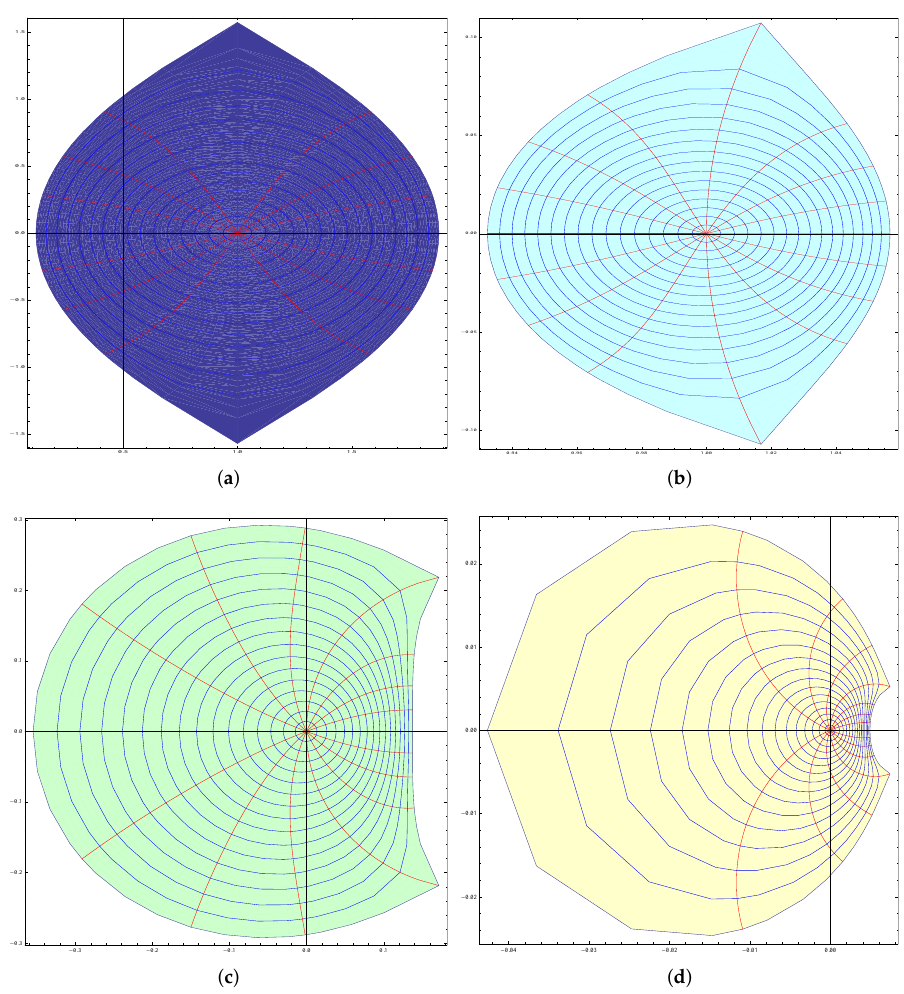
Figure 1. Impact of N ( A , B , ψ ) − 1 on ψ ( z ) = 1 + sinh − 1 ( z ) . ( a ) Mapping of E under the transfor- mation ψ ( z ) = 1 + sinh − 1 ( z ) . ( b ) Mapping of E under the transformation N ( − 0.66, − 0.8, ψ ) − 1 if ψ ( z ) = 1 + sinh − 1 ( z ) . ( c ) Mapping of E under the transformation N ( 0.45, 0, ψ ) − 1 if ψ ( z ) = 1 + sinh − 1 ( z ) . ( d ) Mapping of E under the transformation N ( 0.82, 0.8, ψ ) − 1 if ψ ( z ) = 1 + sinh − 1 ( z )